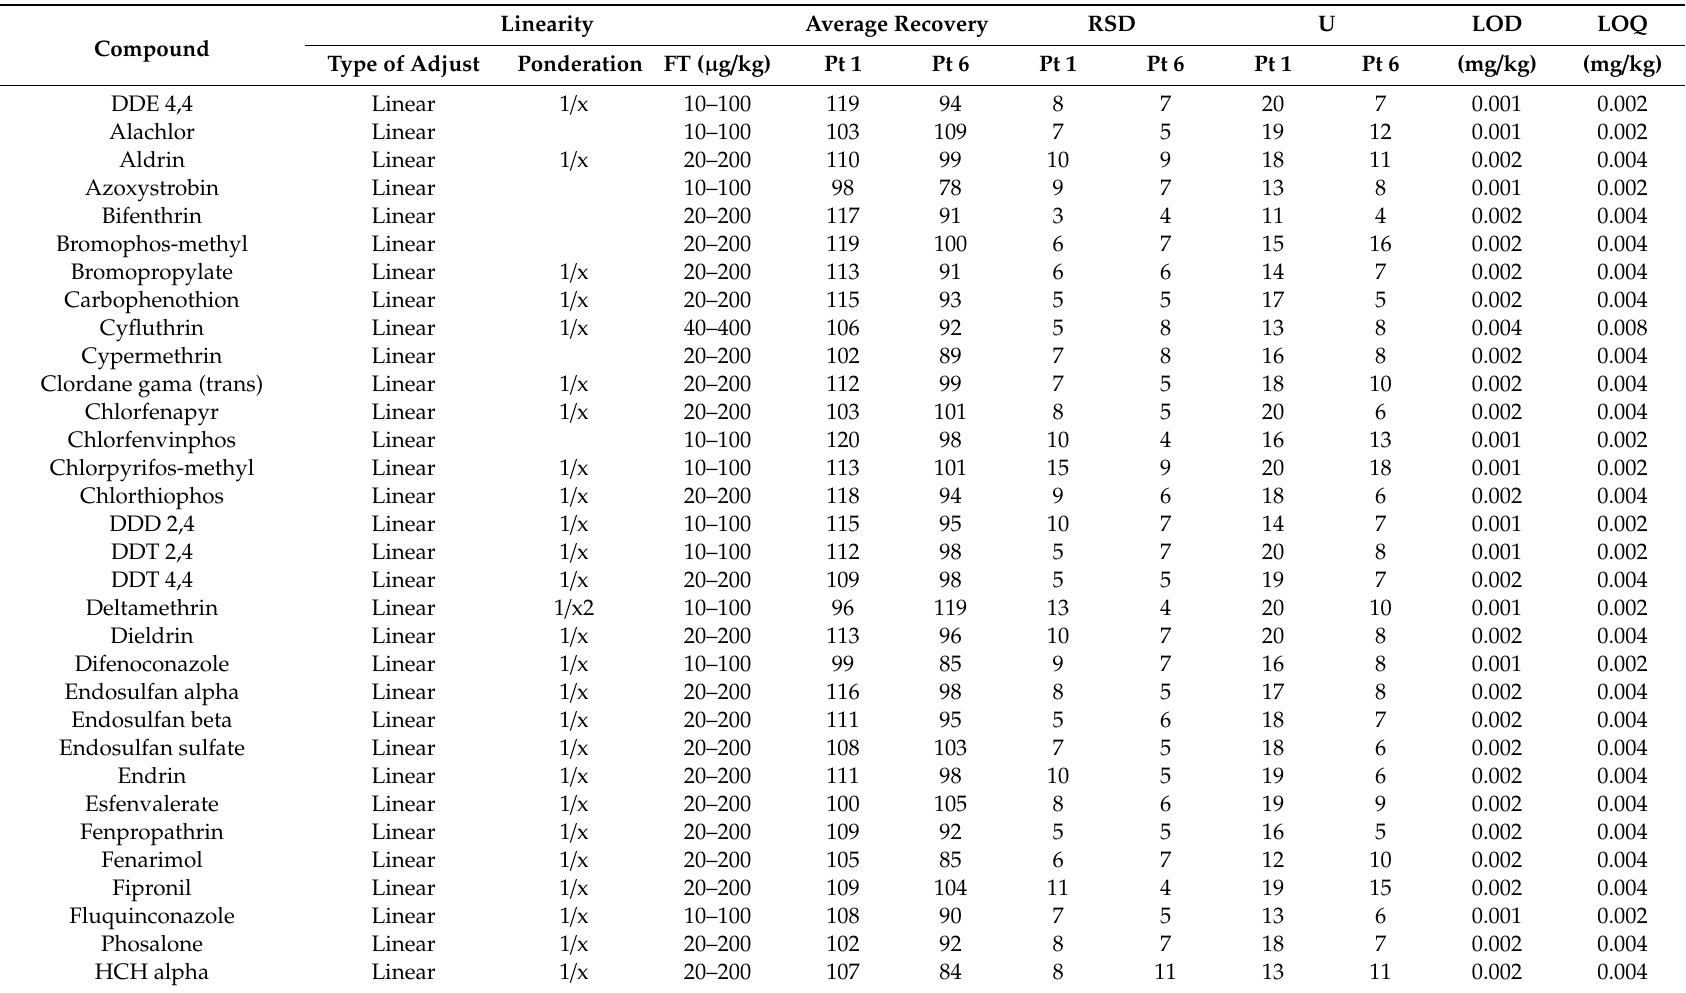
Table 4. Linearity, recovery (in %), repeatability relative standard deviation (RSD; in %), expanded measurement uncertainty (U; in %), limit of detection (LOD; in mg / kg), and limit of quantification (LO Q; in mg / kg) for each analyte of the GC-MS / MS method for analysis of pesticides in